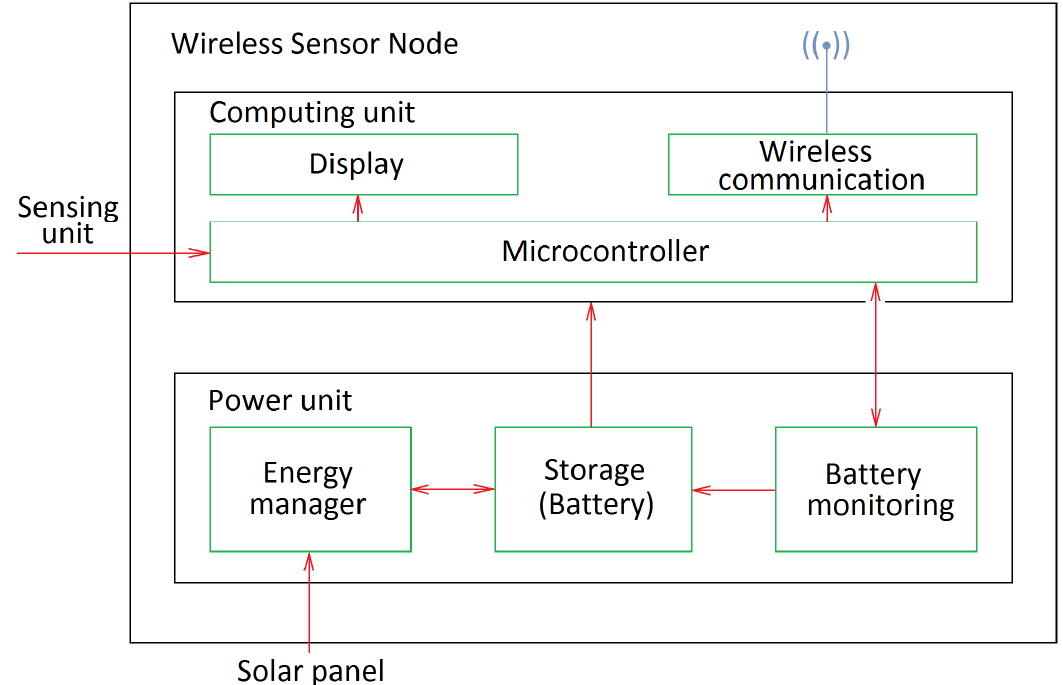
Figure 2. The architecture of the proposed wireless sensor nodes.